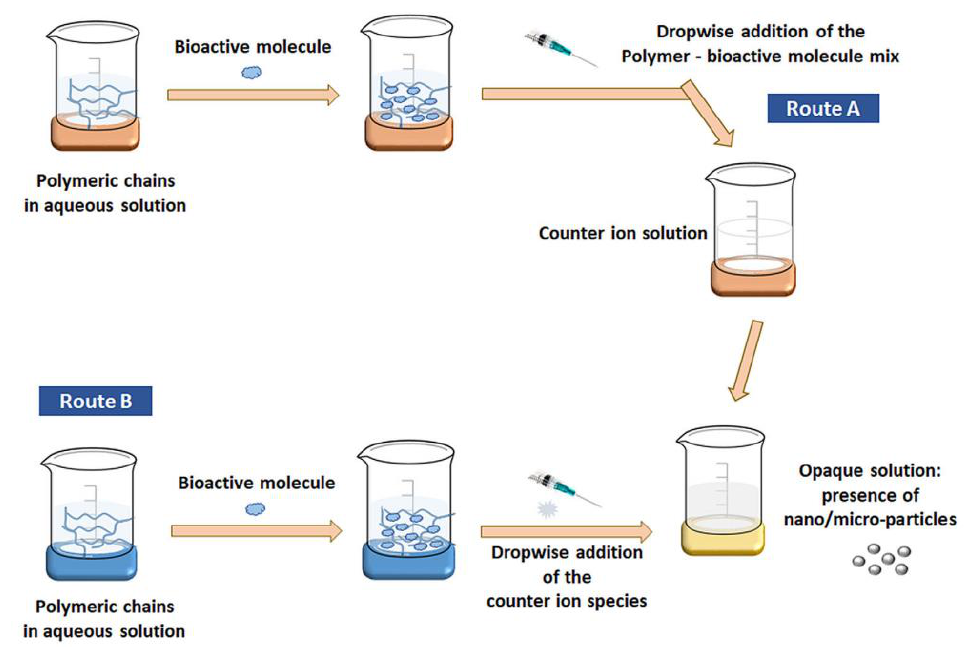
Figure 2. Schematic representation of nanoparticles production via IG method. Reprinted with permission from [64], © 2020, Society of Chemical Industry, Published by John Wiley and